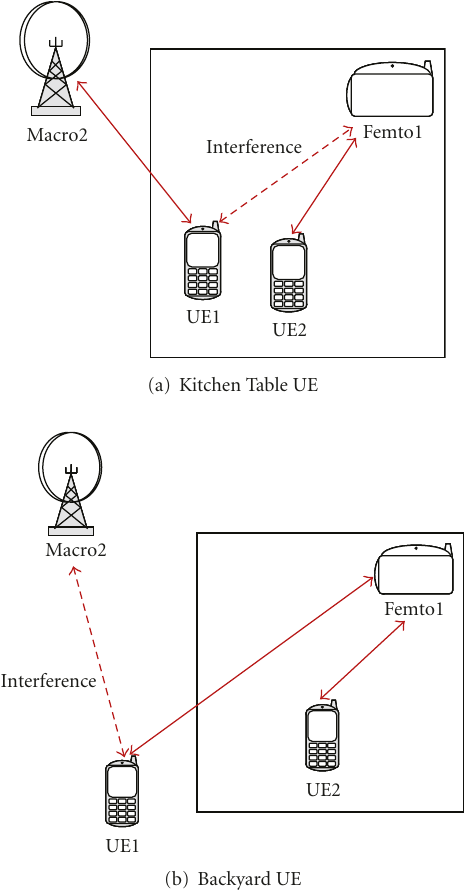
Figure 1: Illustrative examples of two interfering scenarios in the femtocell